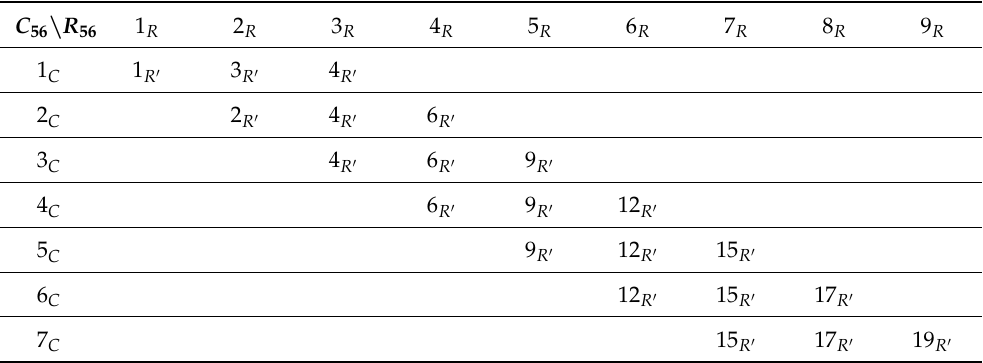
Table 8. Fuzzy rules designed for strong failure correlation Machine pair 5–6. C 56 \ R